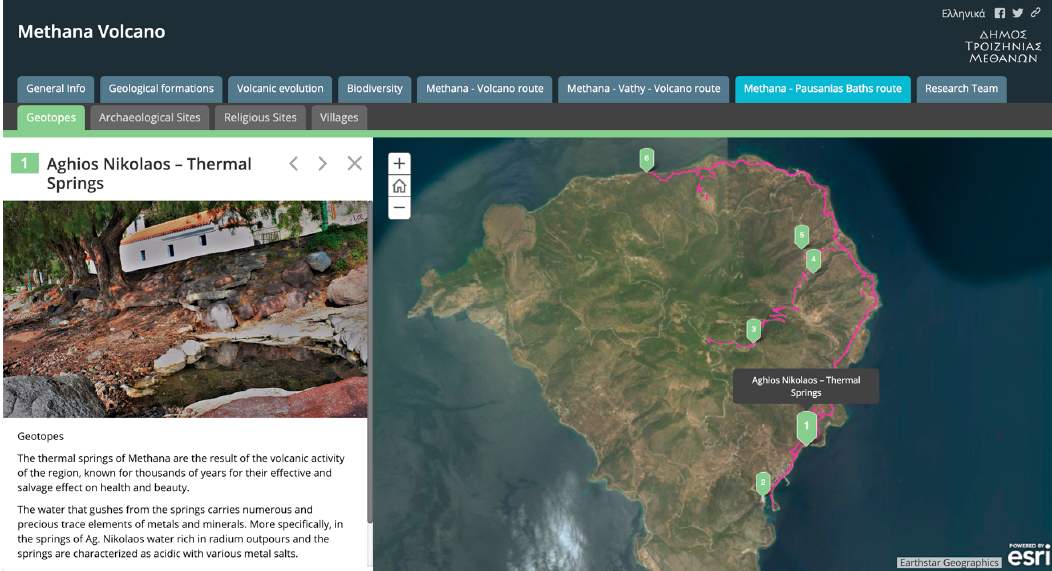
Figure 15. Screenshot of the fifth to seventh tab, where narrative text, multimedia context and external links are used to effectively visualize the available information (https://goo.gl/4BJ2CE).